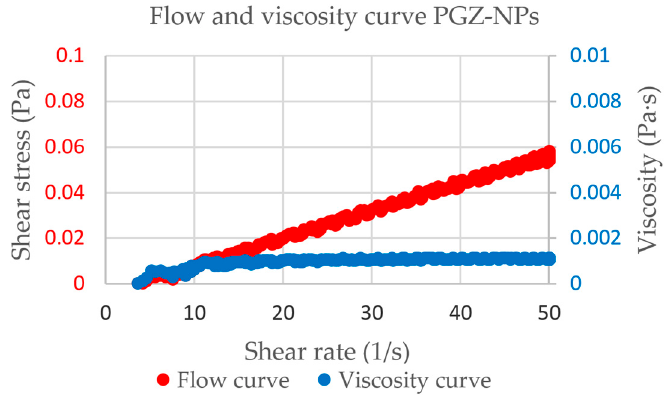
Figure 3. Rheograms obtained for the PGZ-NPs.